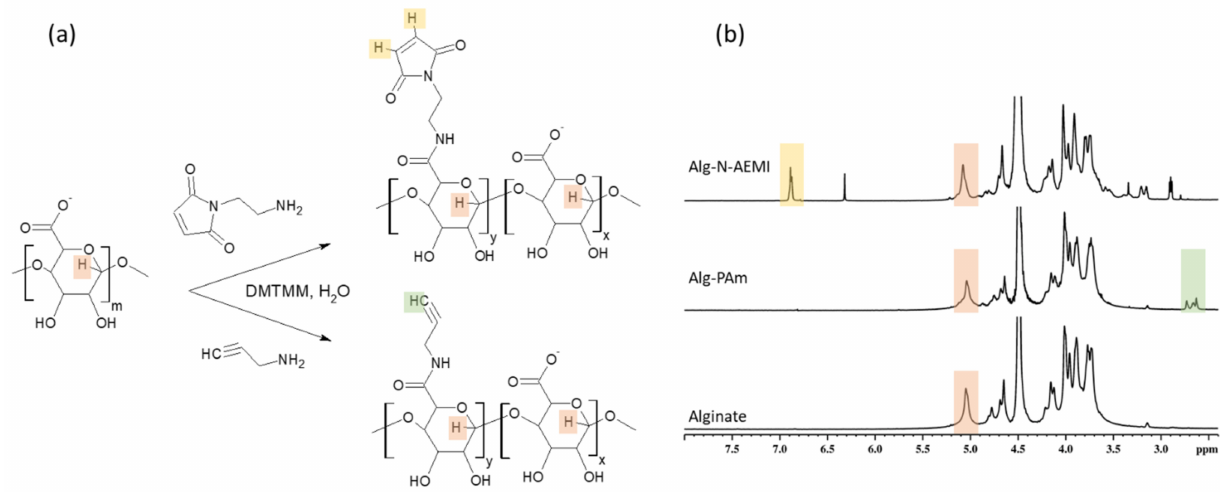
Figure 3. Functional amines conjugation to alginate with help of EDC/NHS coupling. ( a )-scheme of the reaction; ( b ) ◦ C (bottom); 1 H NMR spectrum of Alg-PAm measured in 1 H NMR spectrum of sodium alginate measured in D 2 O at 50 D 2 O at 50 ◦ C (middle); 1 H NMR spectrum of Alg-N-AEMI measured in D 2 O at 50 ◦ C (top). Specific signals proving the modification are marked with